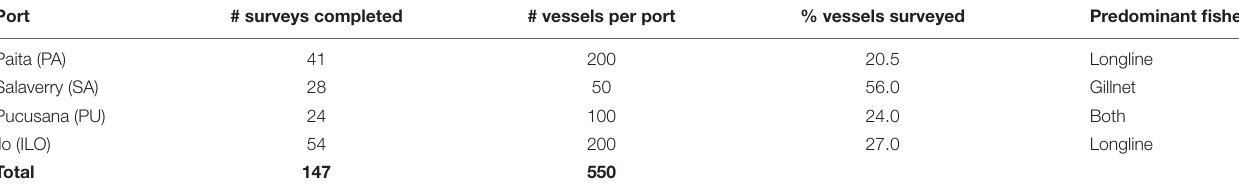
TABLE 1 | Number of surveys and the percent of the fleet covered by the survey for each port. Port # surveys